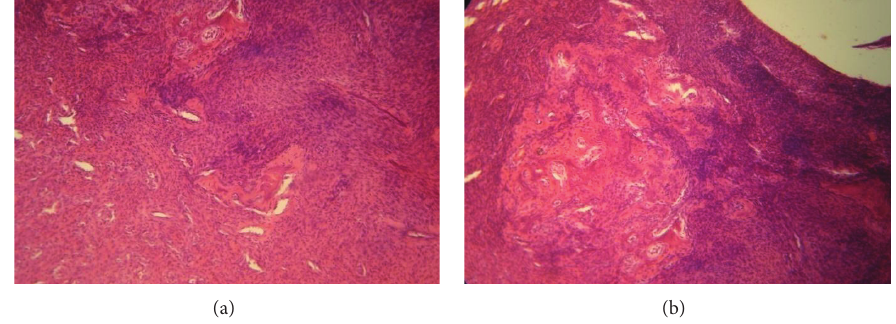
F 5: Histologic view of the lesion under 20x